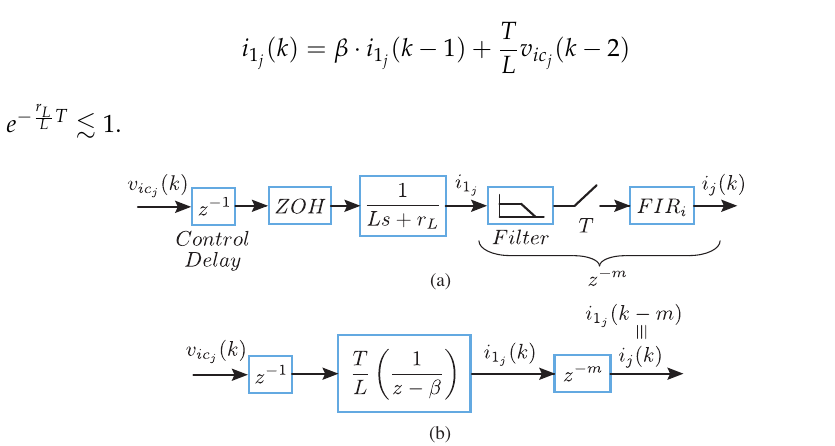
Figure 5. Plant model with: ( a ) anti-aliasing filter, control and FIR delays; and ( b ) equivalent